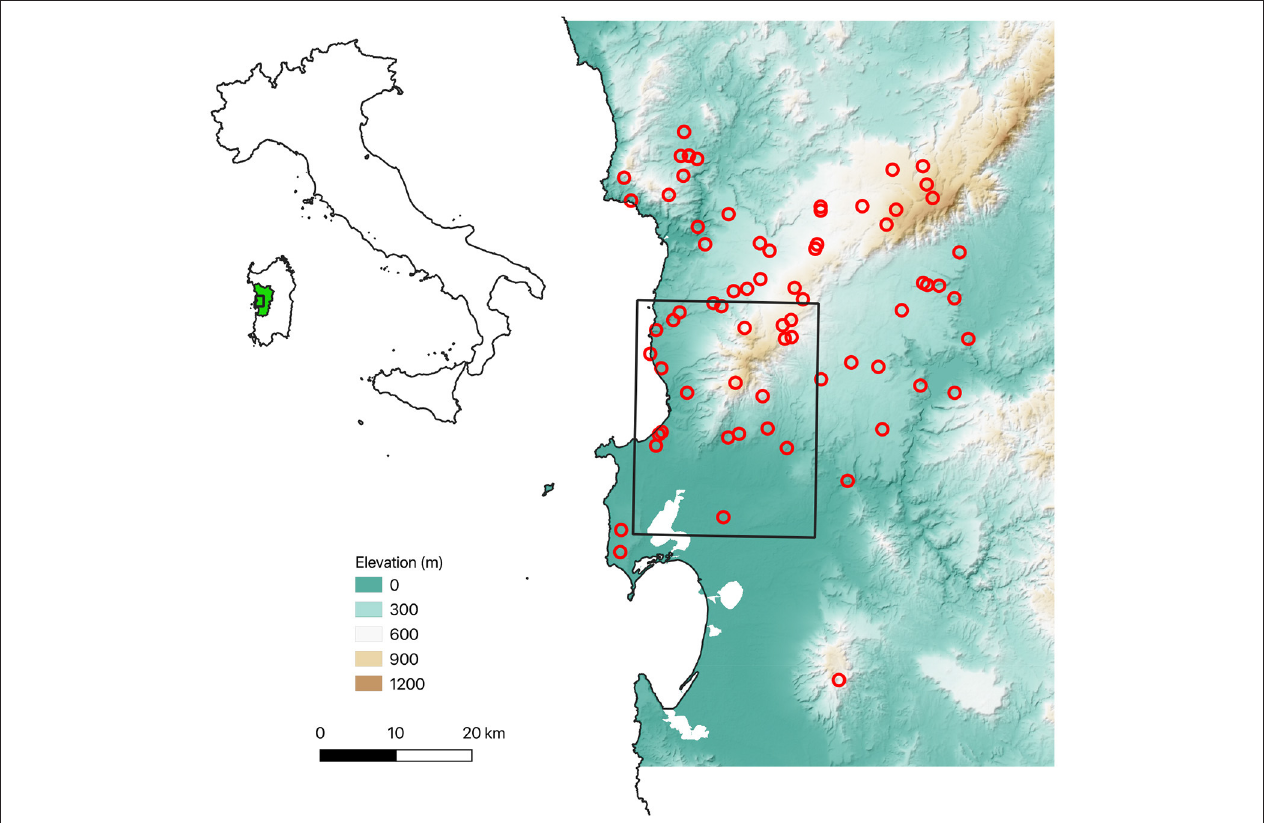
FIGURE 3 | Overview of the sampling plots. The black rectangle marks the grid cell selected from the global ERA5 climate data set, which was used to run the LiBry model (see “Model setup”